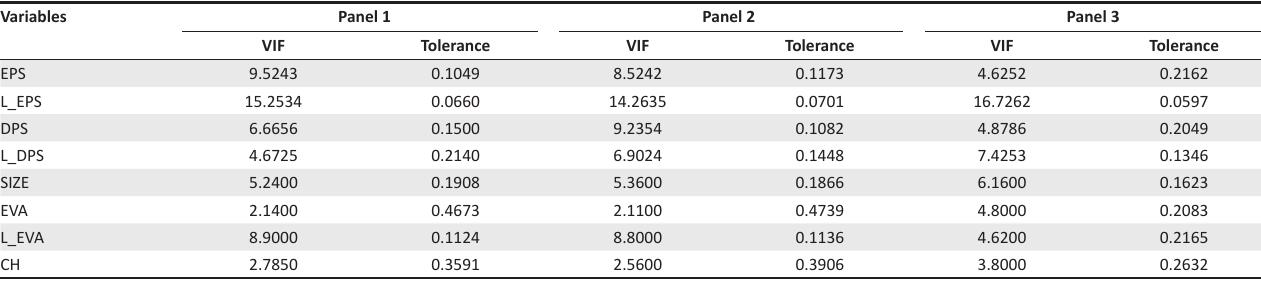
TABLE 8: Test of multicollinearity.